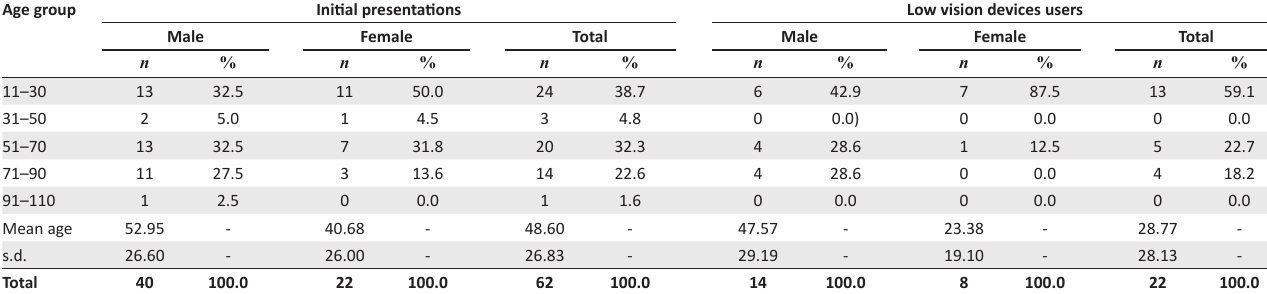
TABLE 1: Demographics of the participants with age group indicated in years ( N = 62). Age